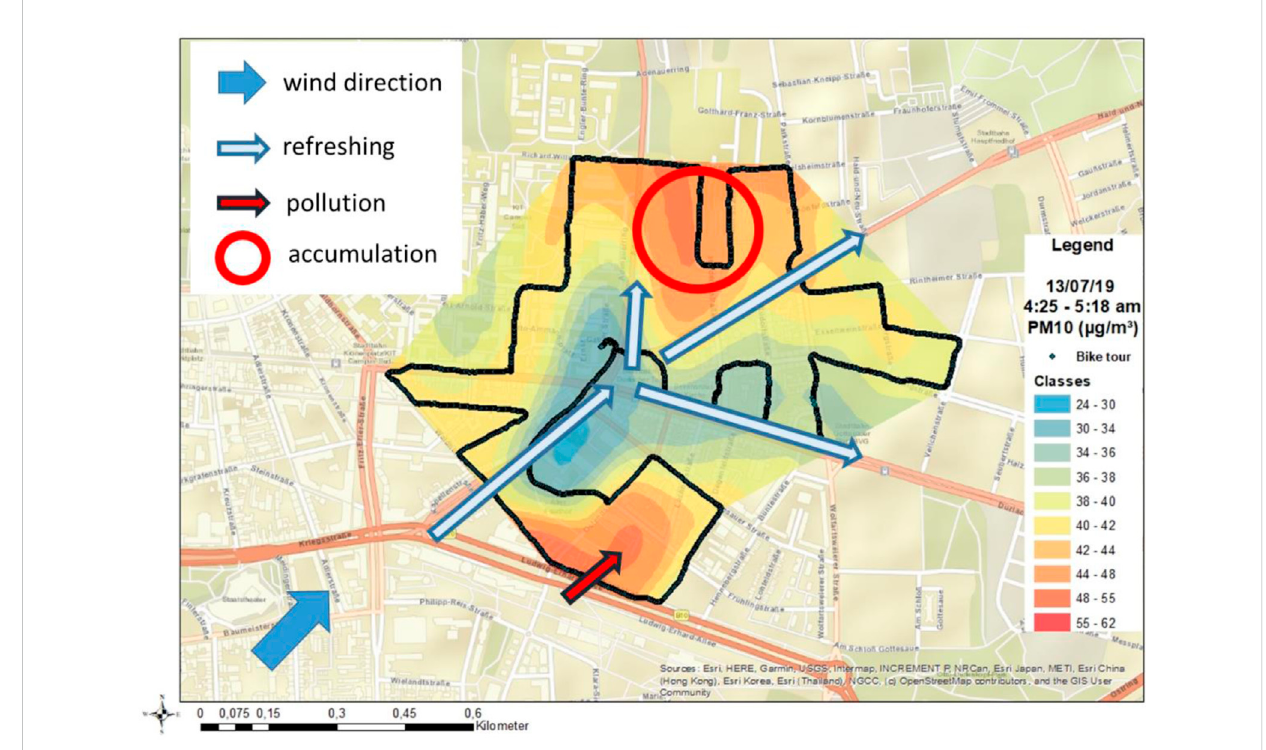
Interaction of wind direction and aerosol distribution pattern on 13th of July during the morning